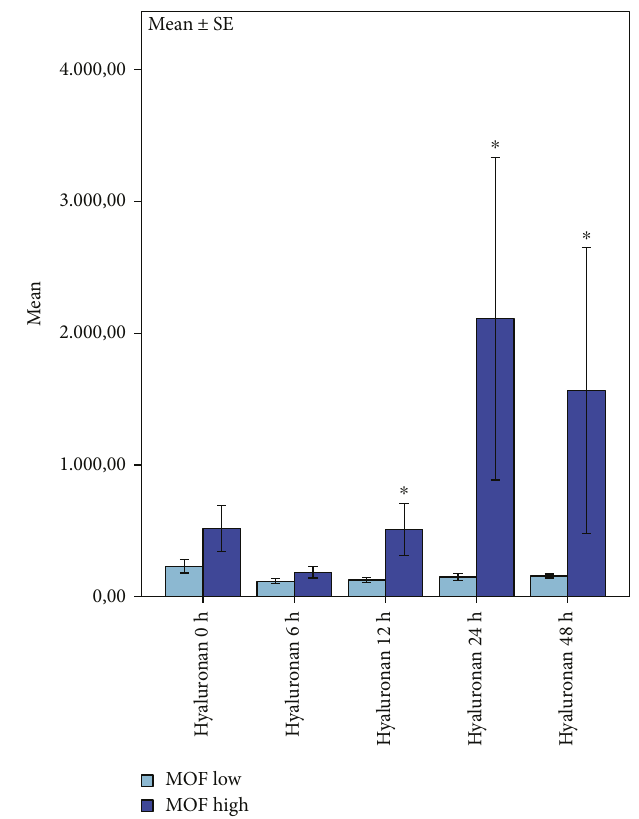
Figure 4: Plots of correlation between hyaluronan concentrations and MOF score 48h after cardiac arrest. Signi fi cant correlation between hyaluronan release, time, and multiple organ failure 0 h-48h after ROSC; bars represent mean values with error bars representing ± 1 SE. ANOVA analysis of variances and the post hoc Mann-Whitney rank sum test; p ≤ 0 05 ; MOF ≤ 6 : n = 9 , MOF > 6 : n = 4